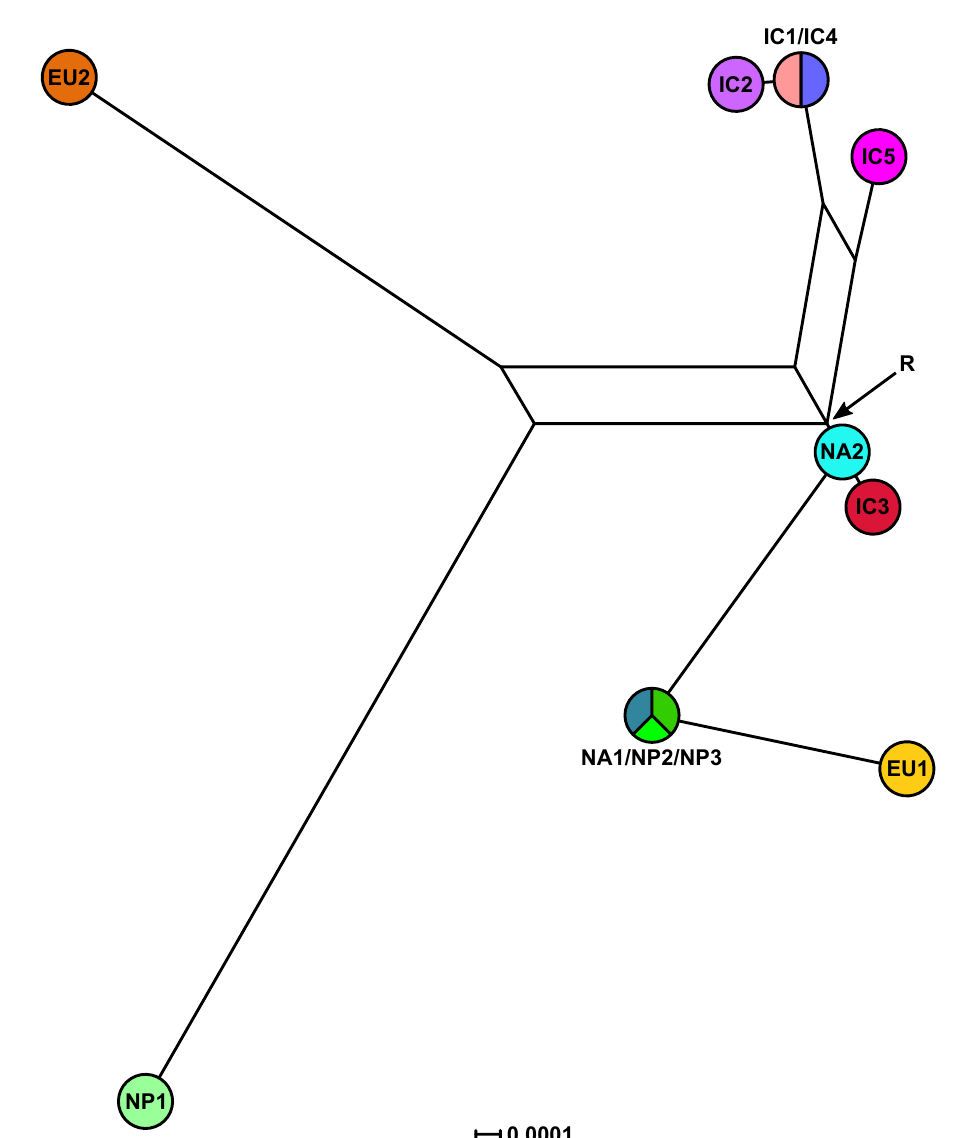
Figure 12. Split decomposition network (SDN) for the five Indochinese lineages (IC1-5), the three Japanese lineages (NP1-3) and the four known lineages (EU1, EU2, NA1 and NA2) of Phytophthora ramorum based on a five-locus mitochondrial ( cox1 , cox2 , nadh1 , Prv8 and Prv9) dataset. Alternative pathways are shown as parallel edges. The node with the highest number of connections and the most central position was designated as root (R). Missing intermediates represent extant unsampled genotypes, extinct ancestors or “false-positives”. The scale bar represents the split support for the